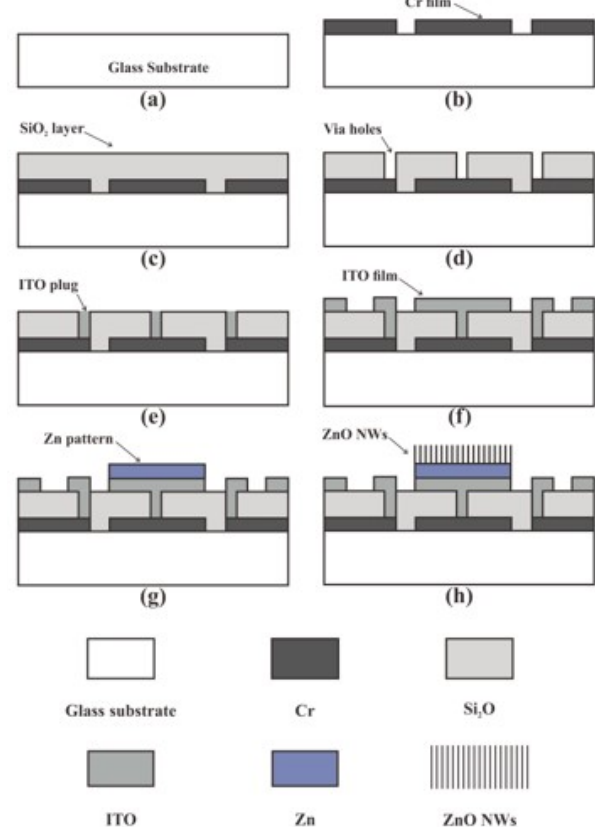
Figure 5. Schematic diagram of the preparation process of ZnO nanowire FEAs. ( a ) Substrate cleaning; ( b ) Cr layer deposition; ( c ) SiO 2 layer deposition; ( d ) via holes etching; ( e ) deposition of ITO plug; ( f ) ITO film deposition; ( g ) Zn film deposition; ( h ) growth of ZnO